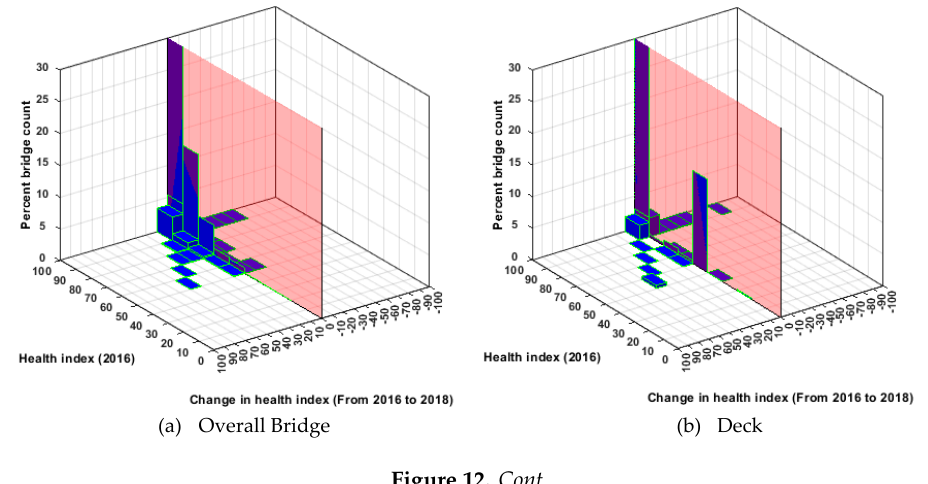
Figure 11. National Highway System (NHS) vs. non-NHS bridge in Pennsylvania.